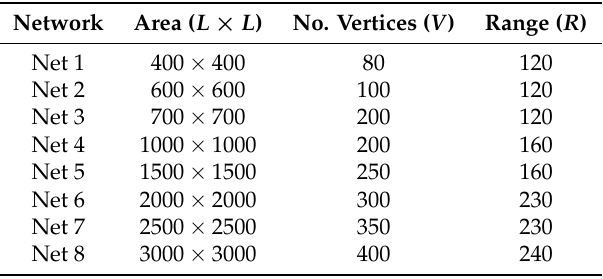
Table 1. Ad hoc network